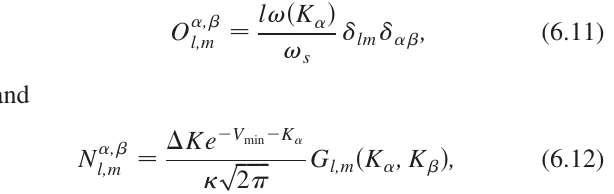
FIG. 2. Wakefield (left) and impedance (right) for the SLC damping ring for (cid:1)